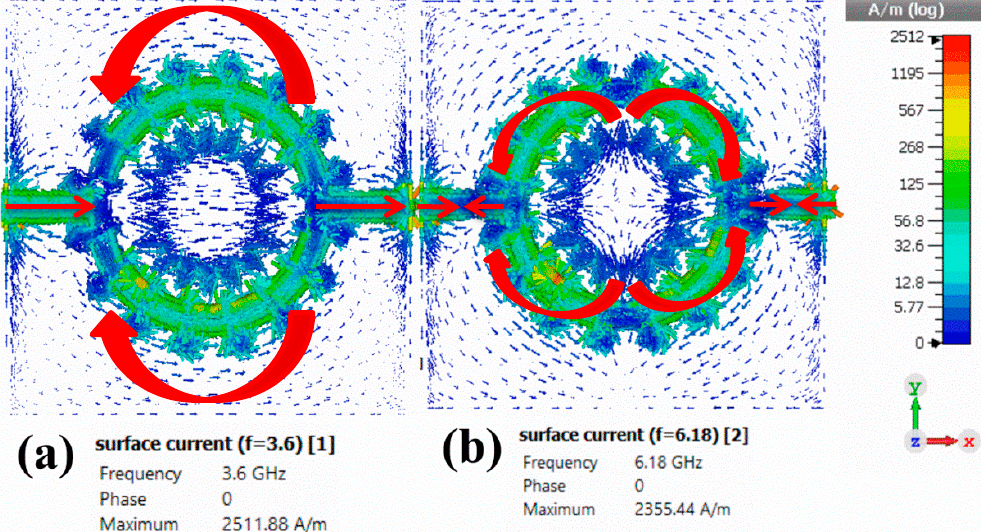
Figure 17. Simulated surface current distribution for the proposed corona-shaped sensor at ( a ) 3.6 GHz and ( b ) 6.16 GHz.